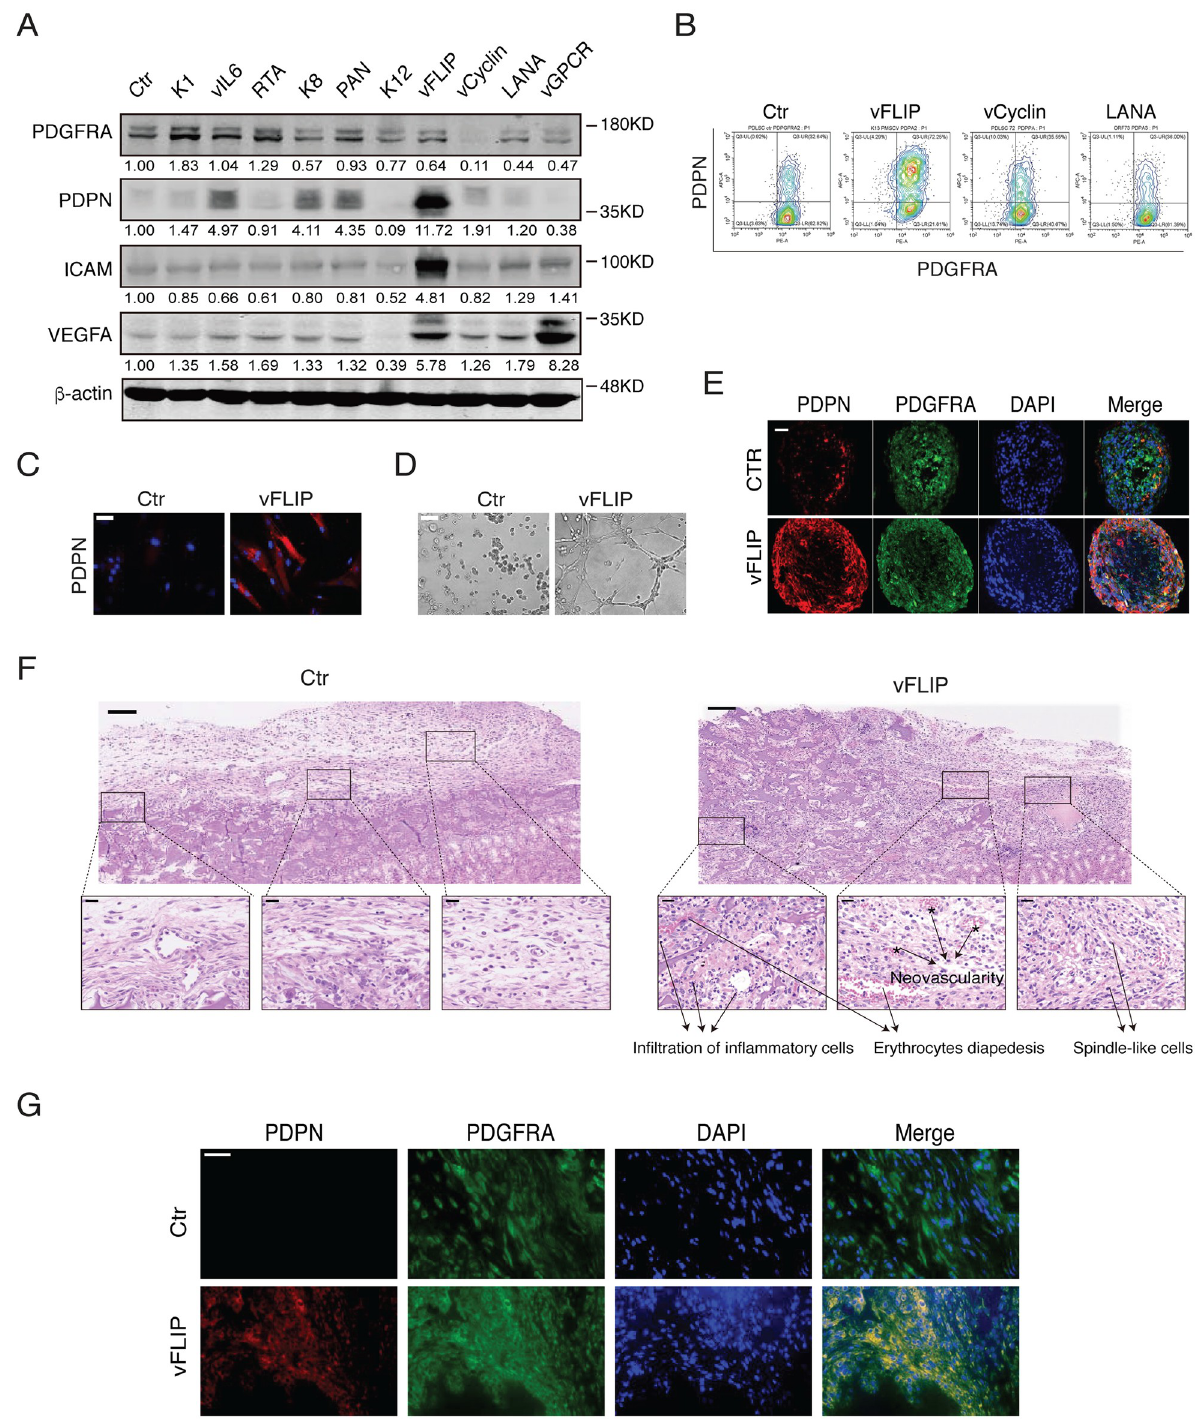
Fig 8. vFLIP promotes MEndT of MSCs and enhances the formation of hybrid M/E state cells and tumorigenesis. (A) PDLSCs were transduced with different viral gene expression vectors as indicated. The expression of some of these viral genes in cells was verified by Western analysis (S2 Fig). The effects of these viral gene products on the expression of PDGFRA, PDPN, ICAM, and VEGFA in PDLSCs were analyzed by Western blotting. (B) vFLIP-, vCyclin- and LANA-expressing PDLSCs were examined for hybrid M/E state cells using FASC. ( C) Immunofluorescence staining of vFLIP-expressing PDLSCs for PDPN expression. Scale bar, 20 μ m. ( D) vFLIP-expressing PDLSCs were subjected to a tubule formation assay. Scale bar, 200 μ m. ( E) vFLIP-expressing PDLSC spheroids were examined by IFA for PDGFRA/PDPN expression profiles. Scale bar, 50 μ m. (F)